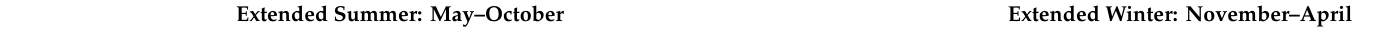
Table 3. Seasonal population-weighted (age, sex) serum 25(OH)D levels and the prevalence of serum 25(OH)D levels < 30, < 50, and < 75 nmol / L (95% CI) for the